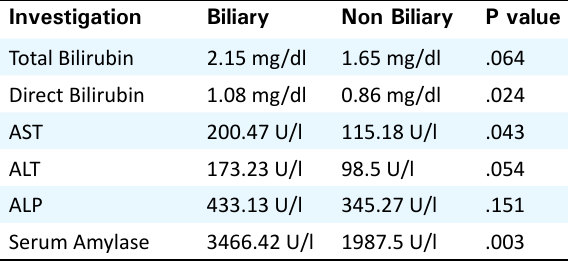
Means of total bilirubin, direct bilirubin, AST, ALT and ALP were higher in biliary group but could not reach statistically significant level. However mean of serum amylase was significantly higher in biliary group (Table 2). Table 2. Comparisons of means of various biochemical